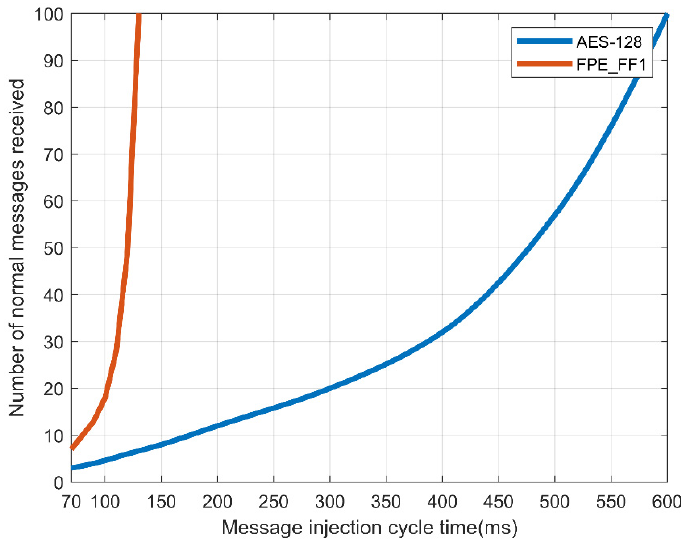
Figure 9. Success rate of message reception by number of controller area network (CAN) messages in a normal message period.